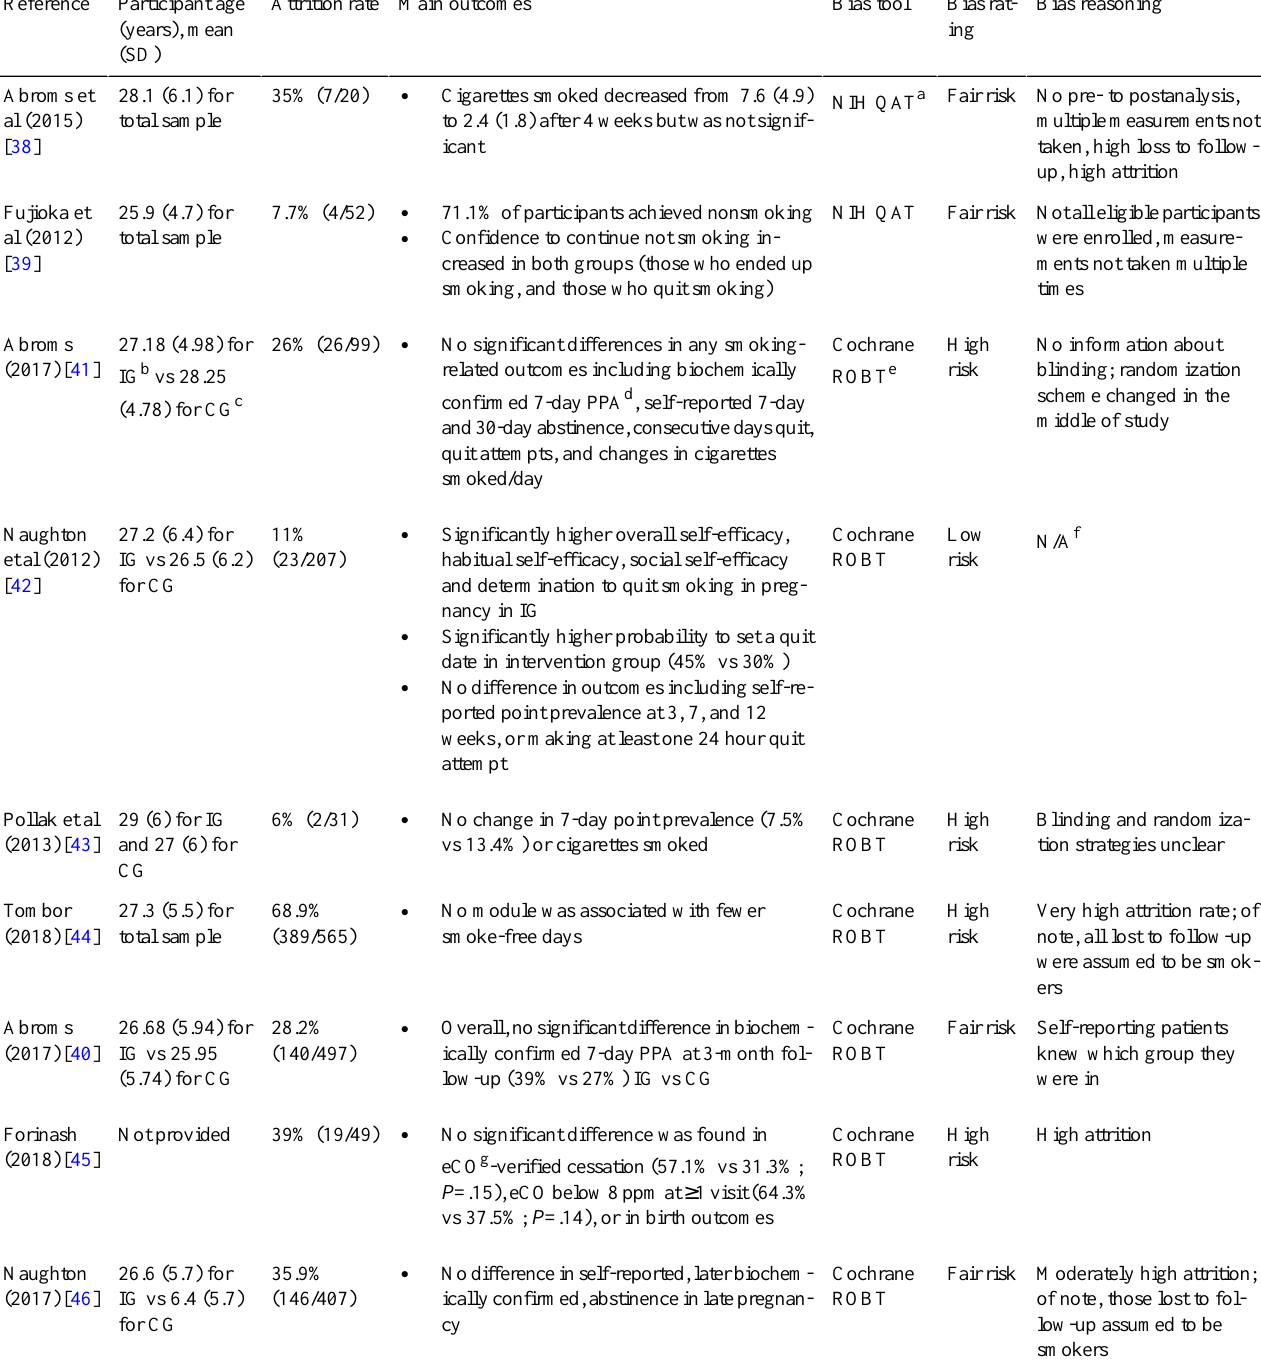
Table 4. Outcomes and bias of trials with a focus on smoking